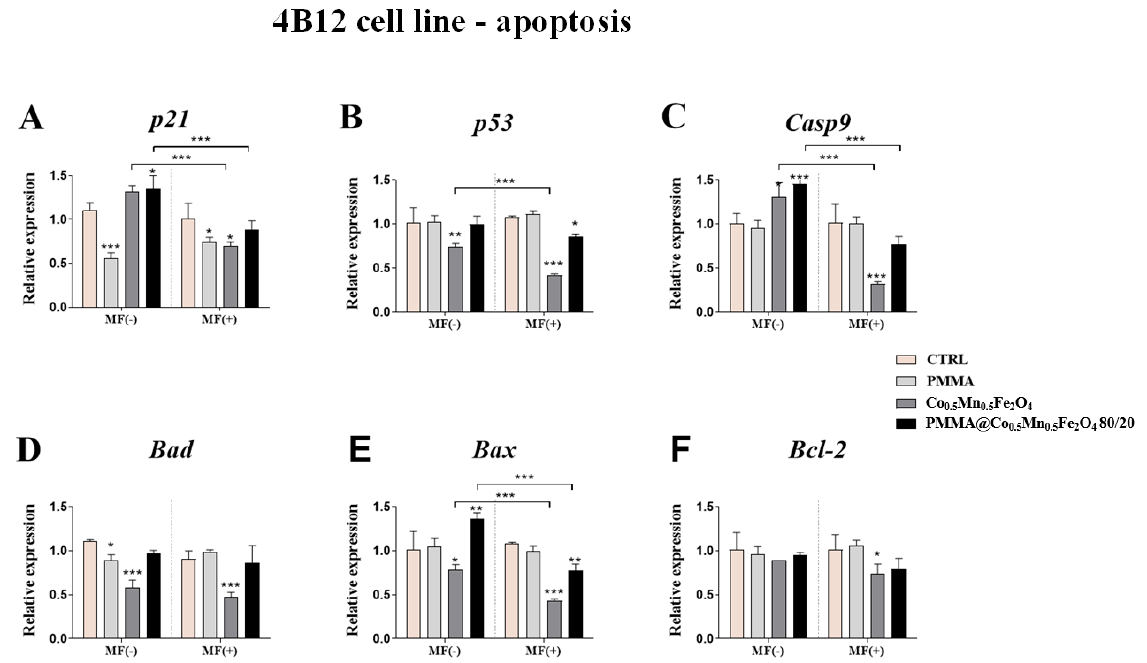
Figure 6. The impact of PMMA and its modification on the expression of genes related to apoptosis: ( p21 ( A ), p53 ( B ), Casp-9 ( C ), Bad ( D ), Bax ( E ) and Bcl-2 ( F )) in the magnetic field condition towards mouse pre-osteoclasts (4B12 cell line). Statistical differences are indicated by * p < 0.005; ** p < 0.001 and *** p < 0.0001.